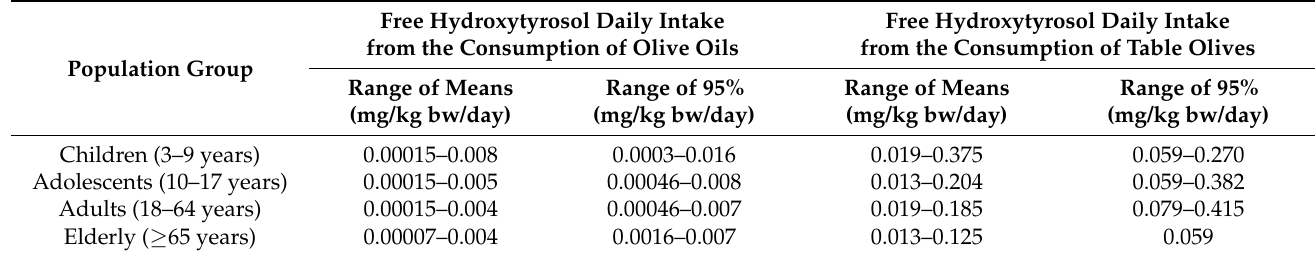
Table 1. Free hydroxytyrosol daily intake from olive and table olive based on the EFSA Comprehen- sive European Food Consumption Database.